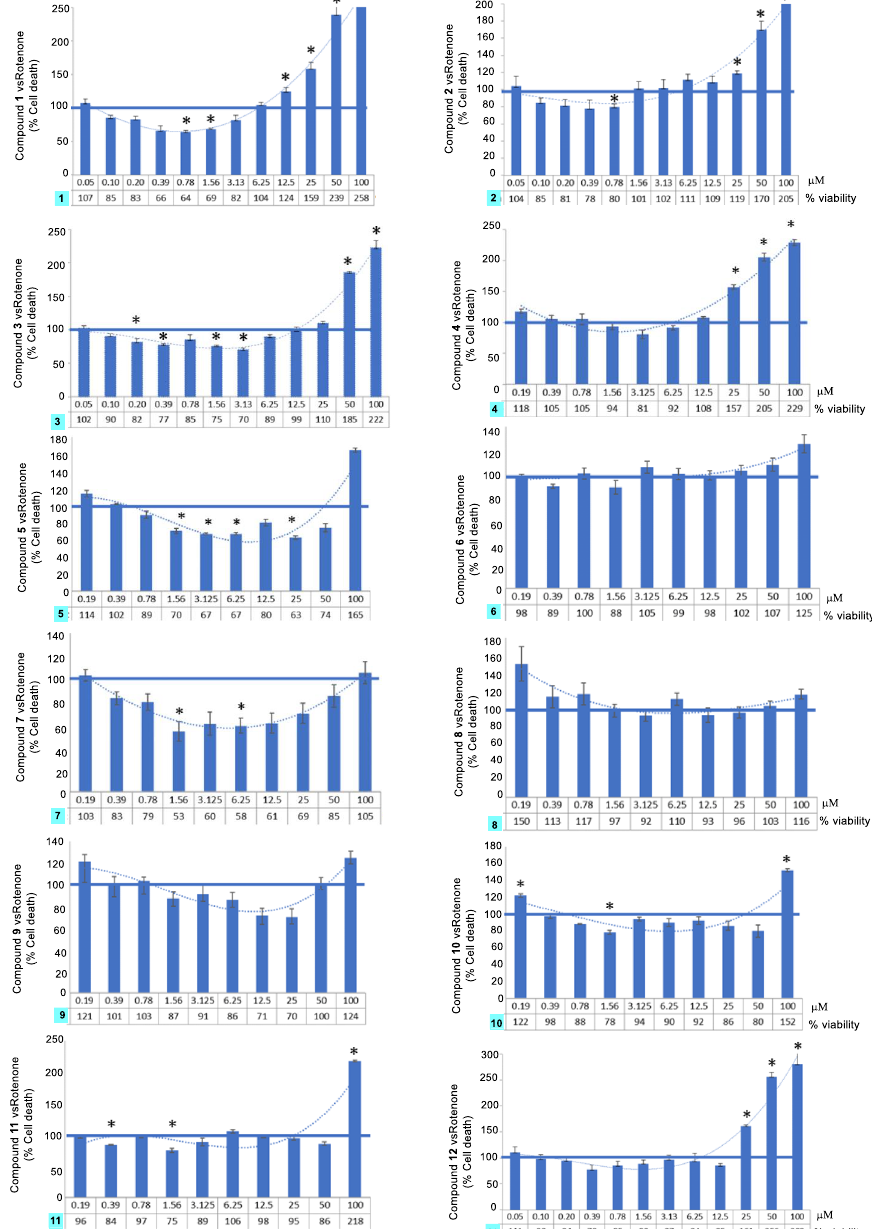
Figure 3. Neuroprotective effect of 1 – 12 against rotenone-induced neuron cell death. Neuroblastoma cells were treated with 2 µM rotenone to induce cell injury. Compounds were assayed at several concentrations (0.1 to 100 µM) for 24 h. Cell death was determined using MTT test. The data represent the percentage of rotenone-induced cell death (means and errors), performed in triplicate. Statistically significance of differences from rotenone-treated cells was examined with the Student’s t-test (* p <